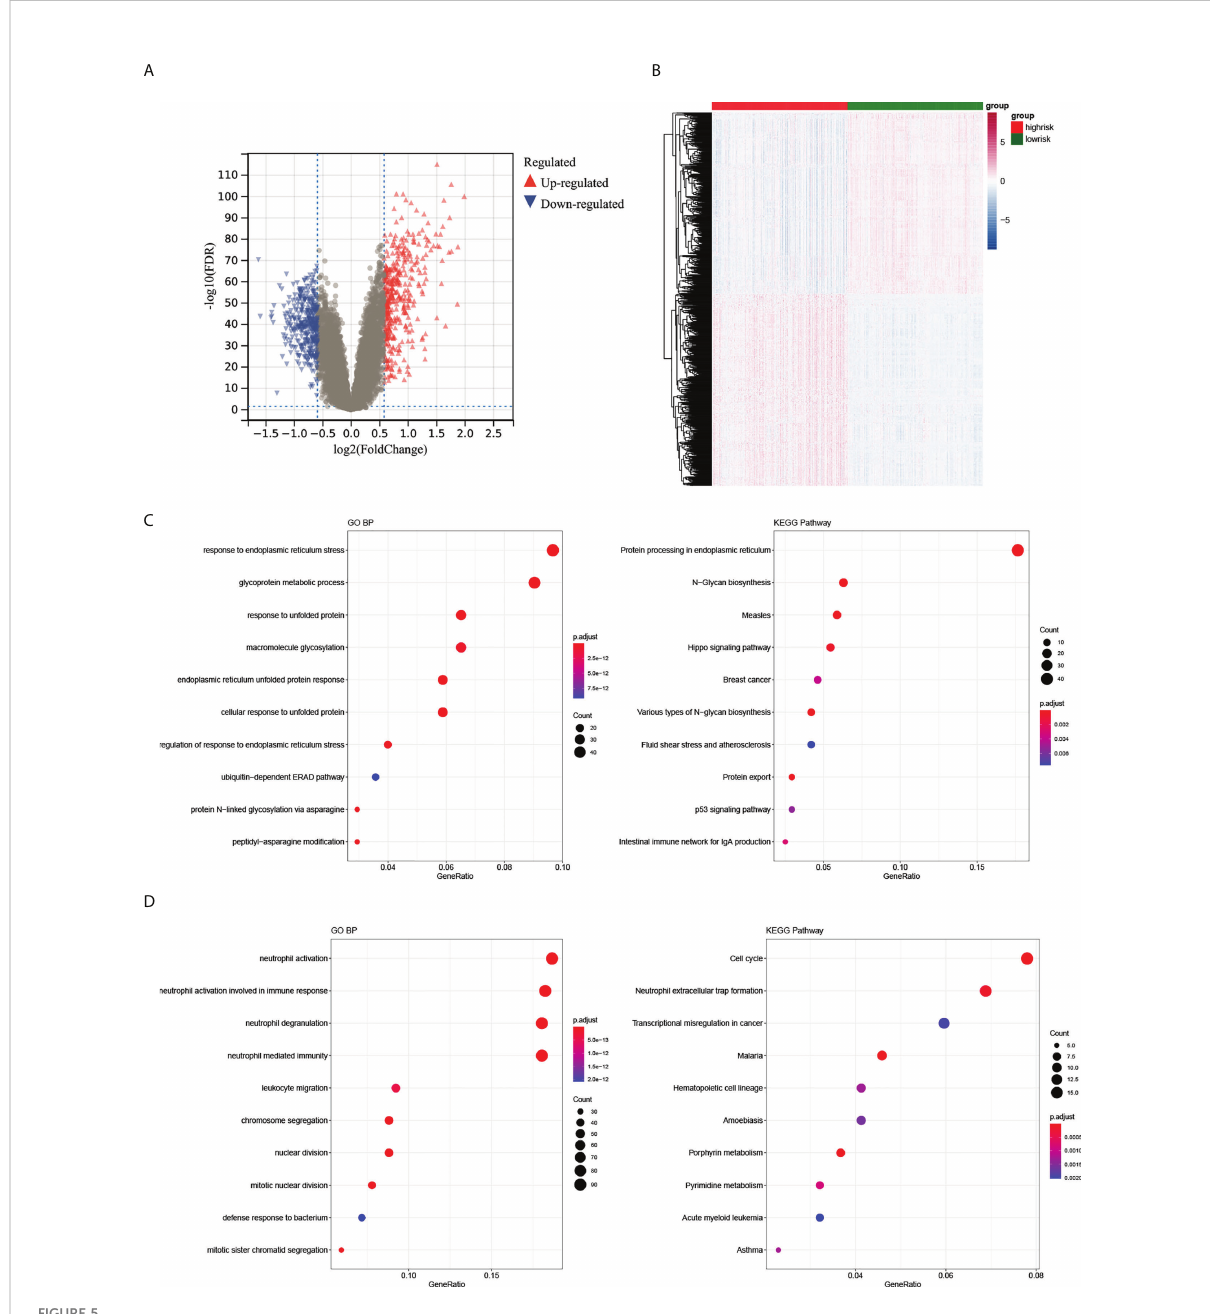
FIGURE 5 Differential expression analysis of high- and low-risk groups. (A, B) The volcano plot and heatmap of DEGs between the two groups. (C, D) The top 10 GO BP and KEGG terms of up- and downregulated DEGs in the two